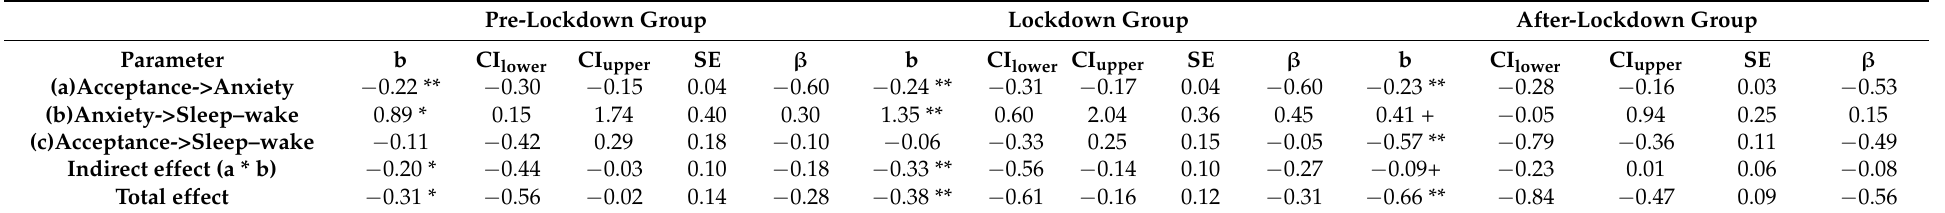
Table 2. SEM estimated coefficients for the configural invariance